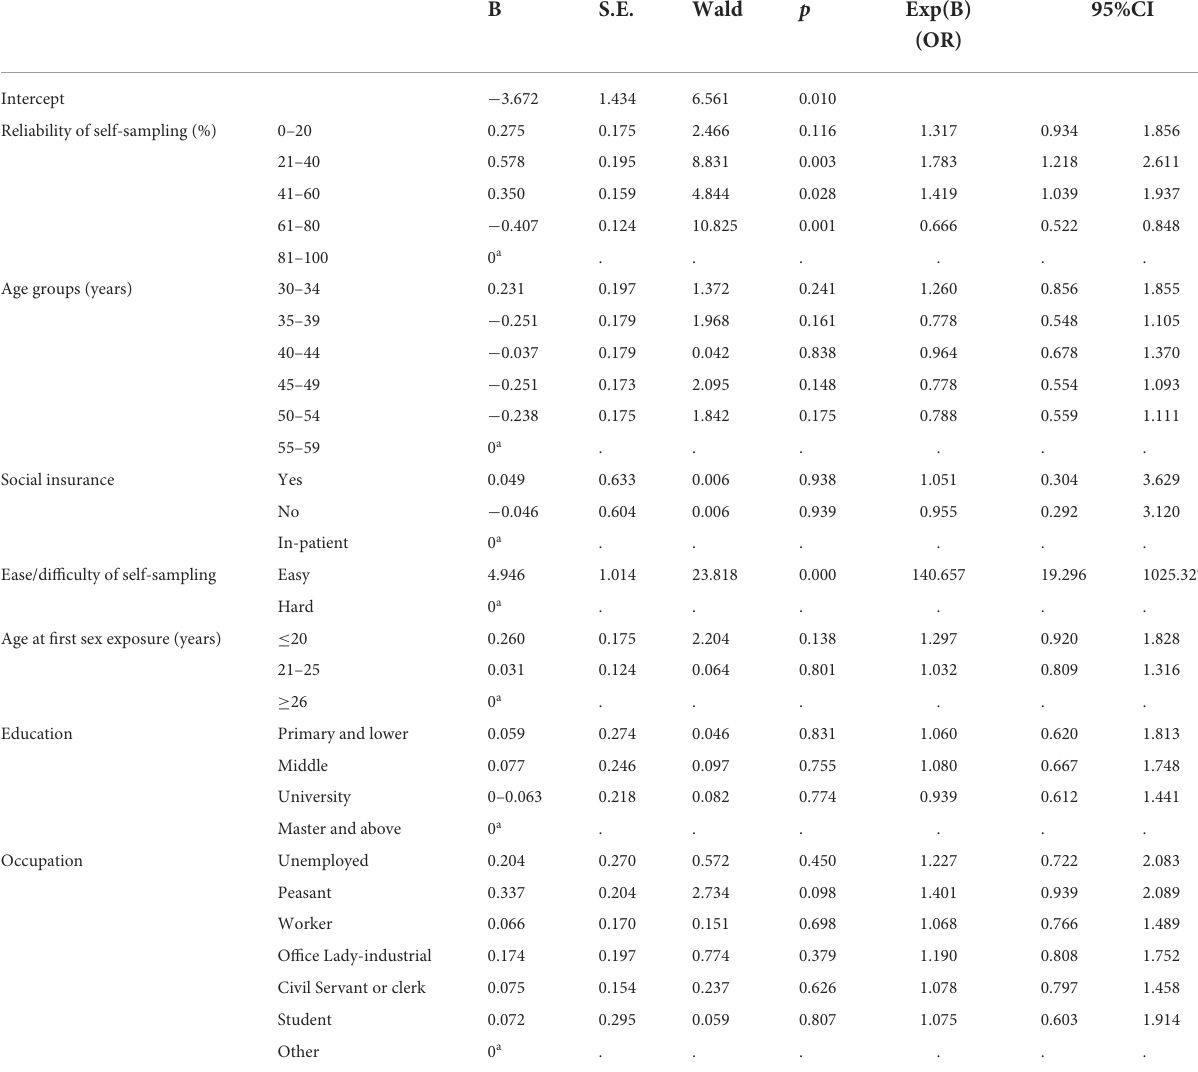
TABLE 4 Multivariate analysis of the factors influencing self-sampling tendency (Binary logistic regression